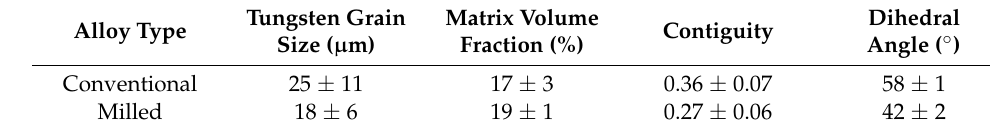
Figure 1. Variation in ( a ) tensile strength and ( b ) elongation with Re addition [50]. Reproduced with permission from Liu et al, Bulletin of Materials Science; published by Springer, 2008. Table 1. Microstructural parameters of the Re added to the tungsten heavy alloy [51].